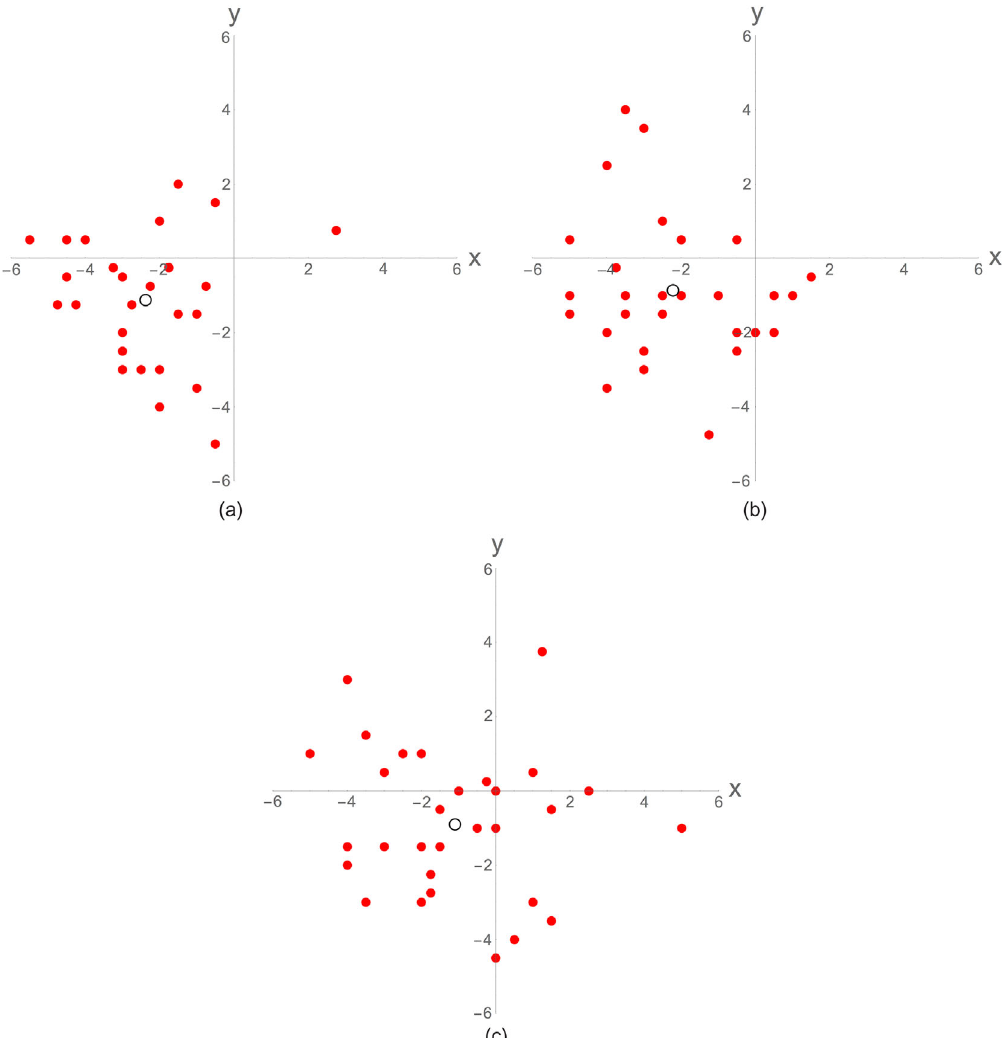
FIG. 2. The centroids (the red dots) and the mean of the centroids (the open circle). (a) Physics faculty. (b) 1st year physics majors and specialists. (c) Physics grad